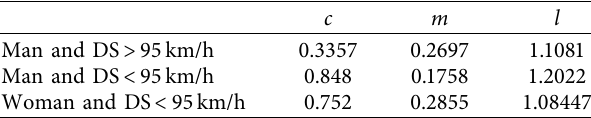
Table 7: The CF parameters based on gender and